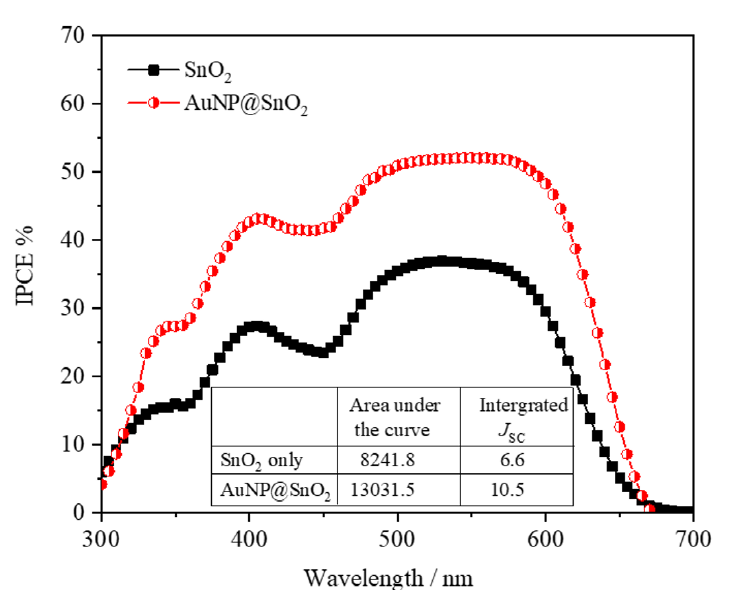
and plasmonic AuNP 2